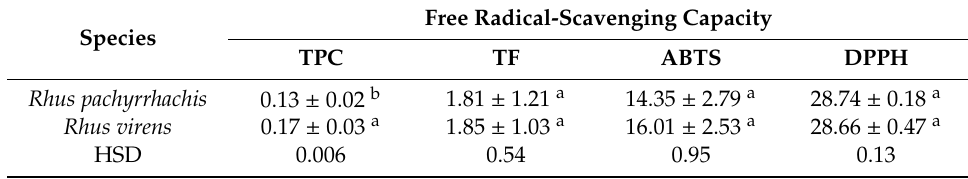
Table 1. Global aggregated results of TPC, TF, and free radical-scavenging capacity against ABTS and DPPH radicals of Rhus pachyrrhachis and Rhus virens .